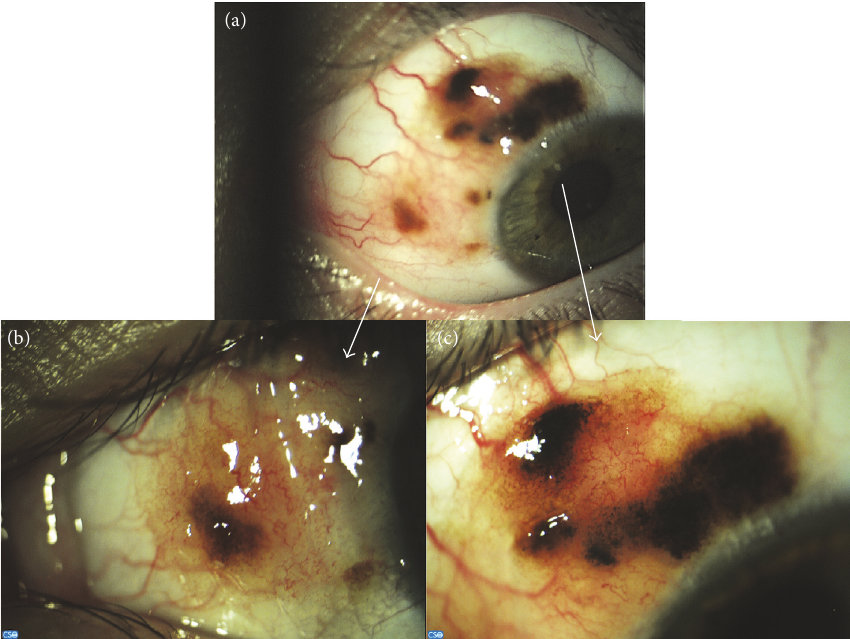
Figure 1: Clinicomorphological appearance of a giant conjunctival nevus (a). Nasal (b) and superonasal (c) parts of the lesion.